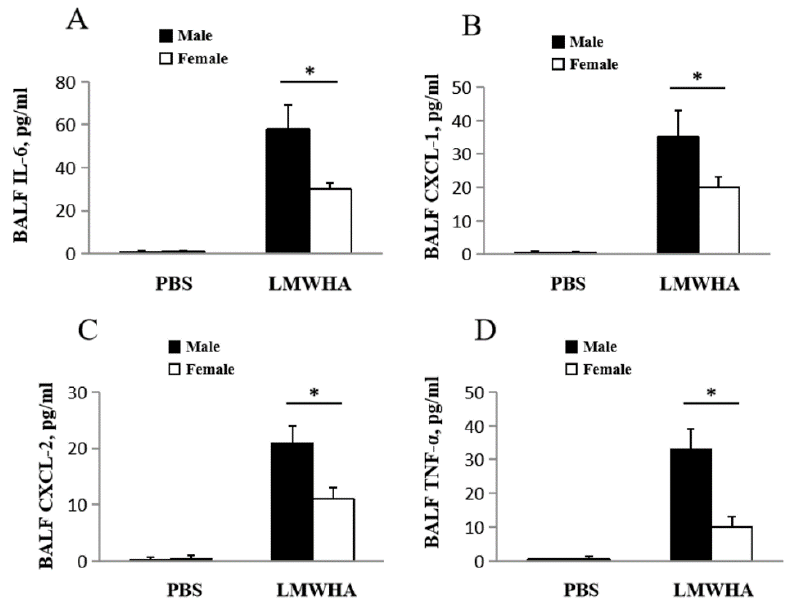
Figure 2. Male mice have a higher level of inflammatory cytokine production compared to that of females 12 h after intratracheal administration of LMWHA (200 kDa, 65 mg/kg). ( A ) IL-6, ( B ) CXCL-1, ( C ) CXCL-2, and ( D ) TNF-α in BALF were analyzed. Values are means ± SEM from at least five individual animals. Significant differences are indicated by *, p < 0.05.